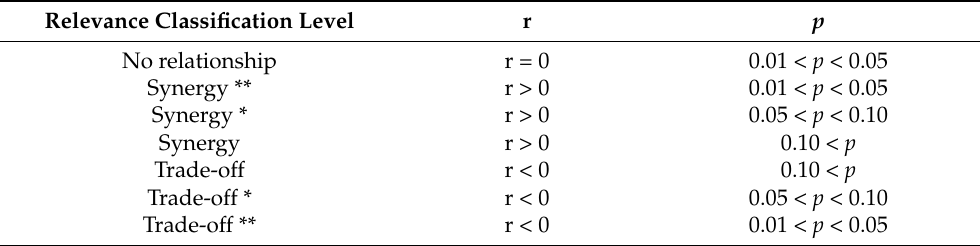
Table 1. The relevance classification level of trade-off and synergy relationships between ecosystem services.